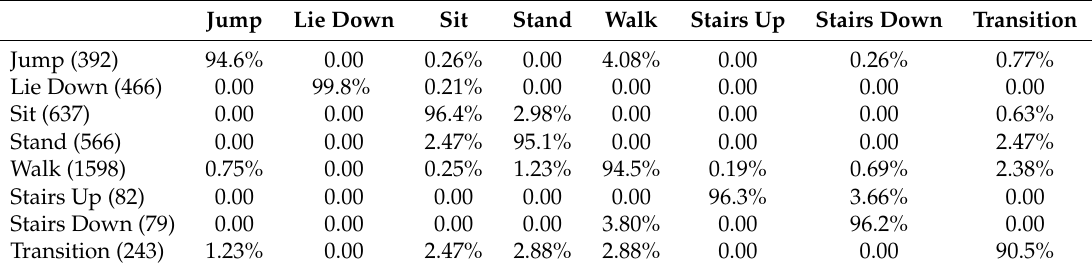
Table 6. Confusion matrix for 18 training users.